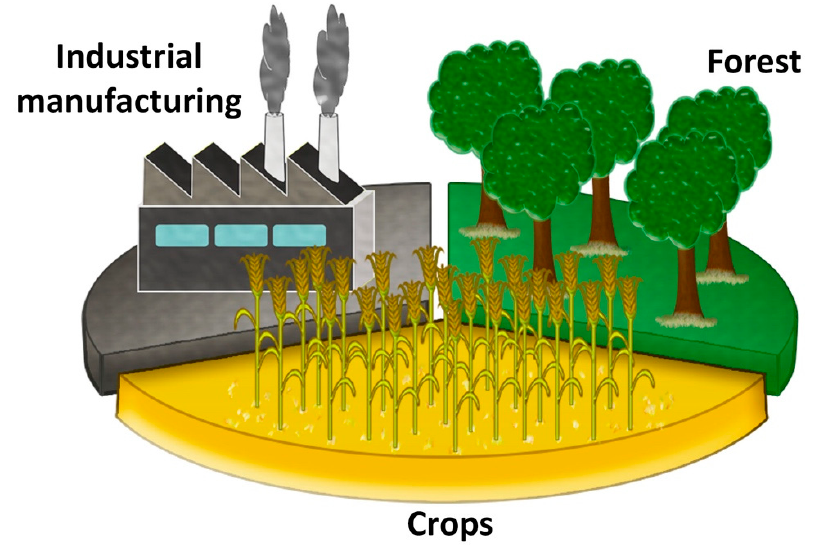
Figure 1. Principal vegetal biomass sources according to Tursi [11] and Kaltschmitt [12] .